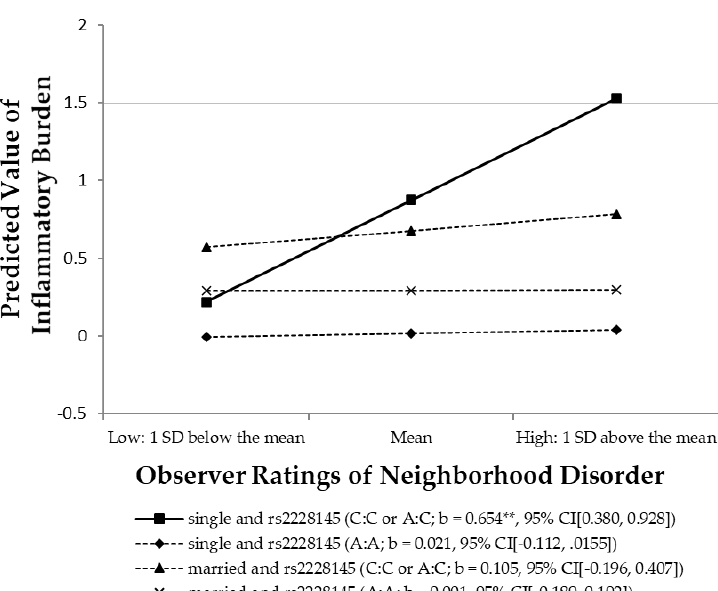
Figure 3. The Effect of Observer Ratings of Neighborhood Disorder on the Inflammatory Burden by rs2228145 and Marital Status. Numbers in parentheses refer to simple slopes with 95% confidence intervals. ** p < 0.001.